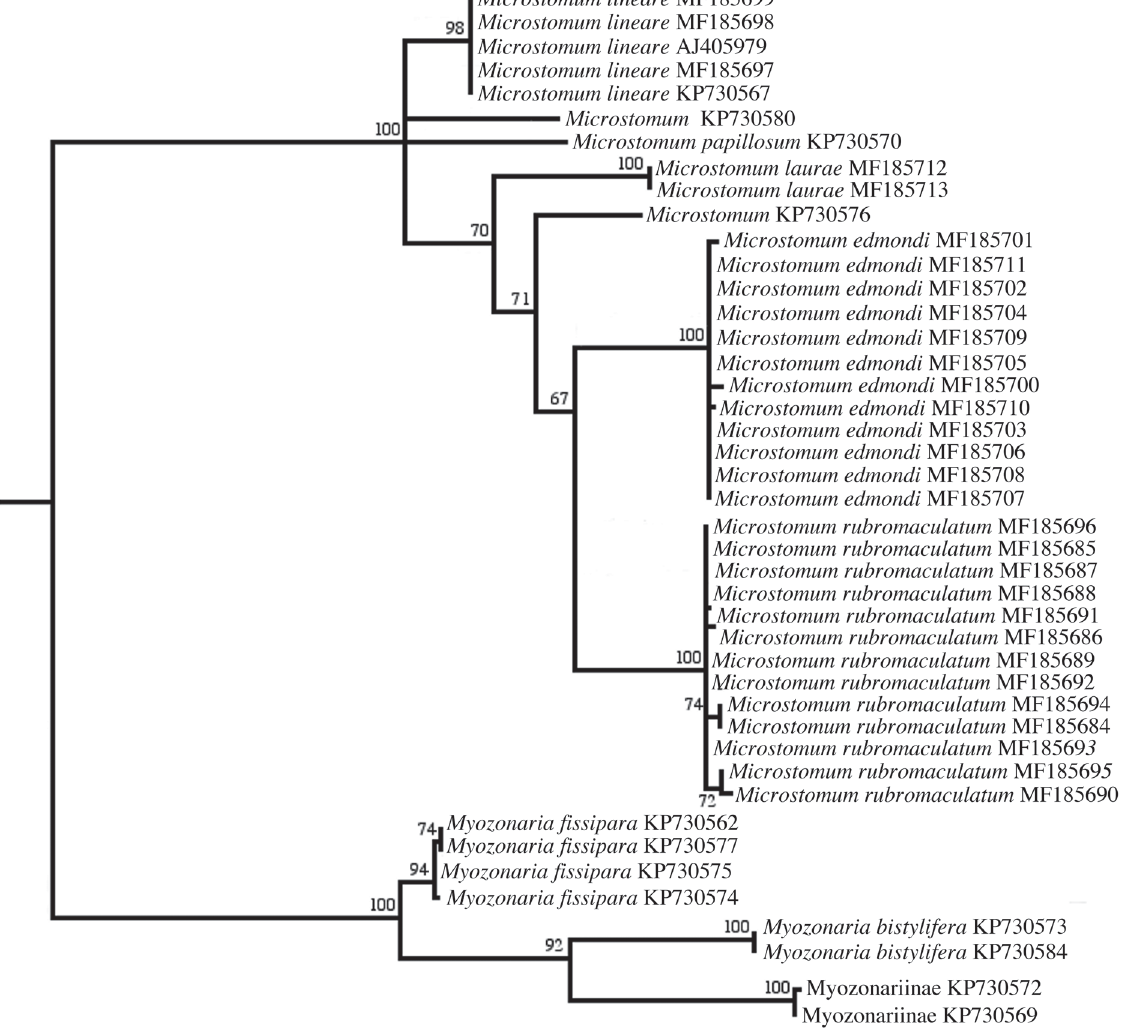
Fig. 6. Phylogenetic relationships of Microstomum Schmidt, 1848 inferred from ML analysis of partial COI gene. Outgroups were selected based on the phylogenetic hypothesis presented in Janssen et al. (2015). Numbers at nodes represent bootstrap support. Genbank accession numbers are listed after each taxon